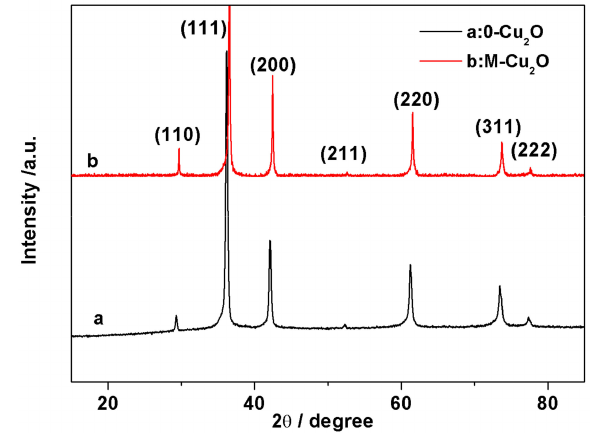
Figure 1. Powder X-ray di ff raction (XRD) pattern of the 0-Cu 2 O and M-Cu 2